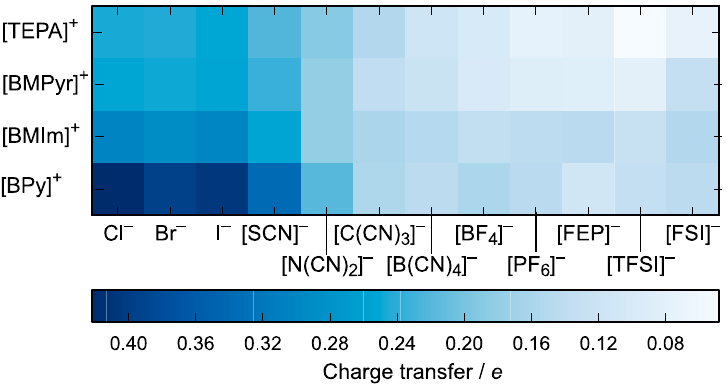
Figure 4. Charge transfer in the ionic pairs from anion to cation calculated using CHELPG method.